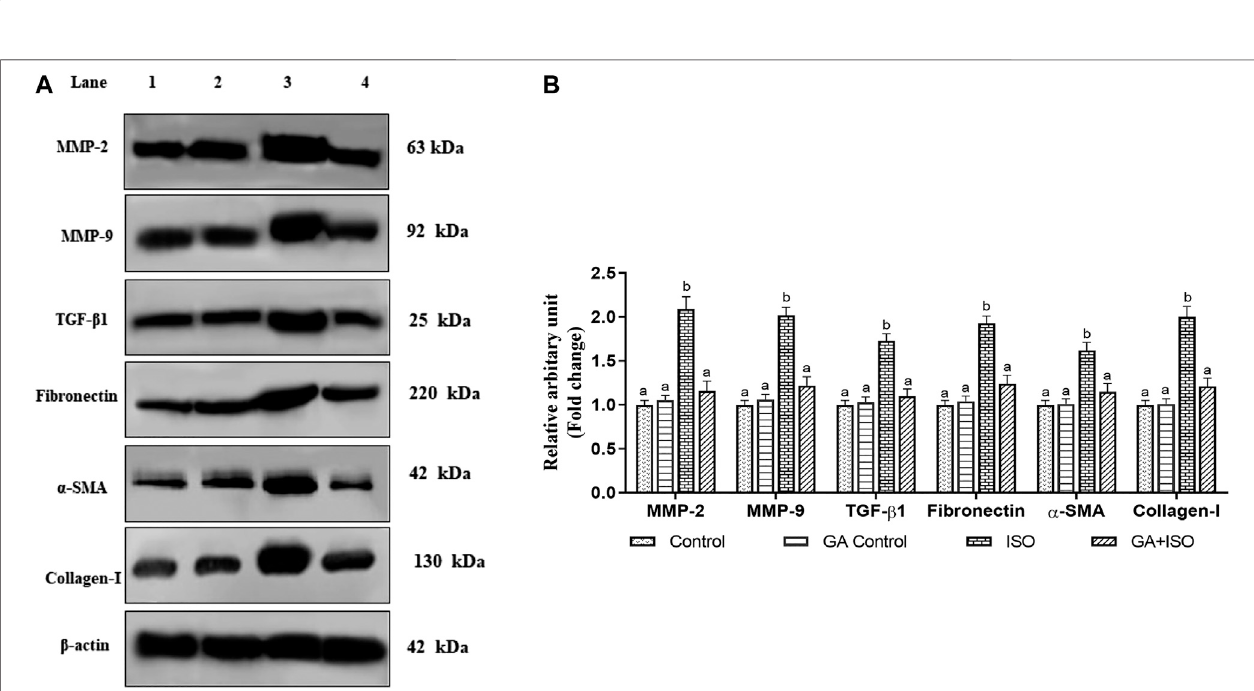
FIGURE 6 | Effect of GA on MMP-2, MMP-9, TGF- β 1, fi bronectin, a -SMA and Collagen-I protein expression in the heart tissue of control and ISO-treated rats. (A) WesternblotwascarriedoutfortheanalysisofMMP-2,MMP-9,TGF- β 1,Fibronectin, a -SMA,andCollagen-IexpressionandtheimageswereacquiredbyLI-CORusing chemiluminescence substrate. Lane 1. Control; Lane 2. GA control; Lane 3. ISO Control; Lane 4. GA + ISO. (B) The quanti fi cation of protein was performed by densitometric analysis using Image-studio software (LI-COR, United States). The densitometry data represent means ± SD from three immunoblots are shown as the relative density of protein bands normalized to ß -actin. Values not sharing a common superscript (a,b,c ... differ signi fi cantly at p < 0.05 (DMRT).